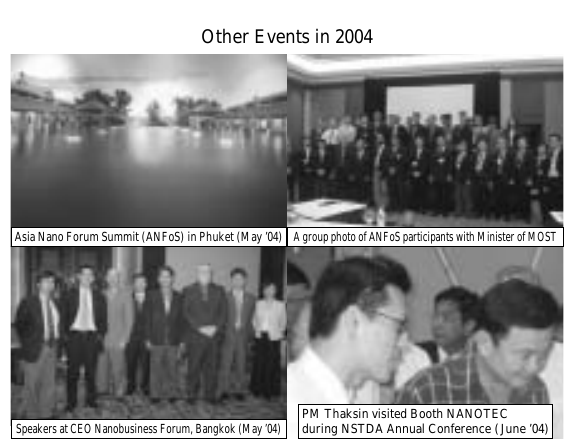
Fig. 3 Photos of selected activities carried out by NANOTEC in 2004